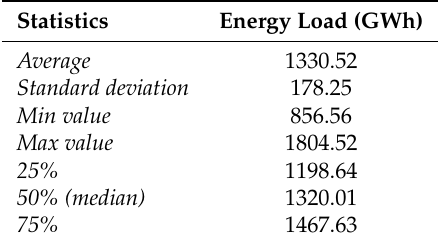
Table 6. Descriptive statistical analysis of the Brazilian energy demand.